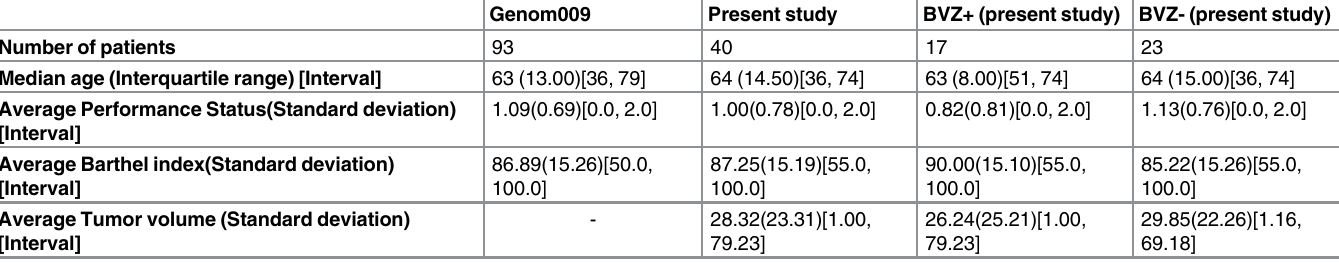
Table 2. Comparison of classical prognostic biomarkers values between the different patient